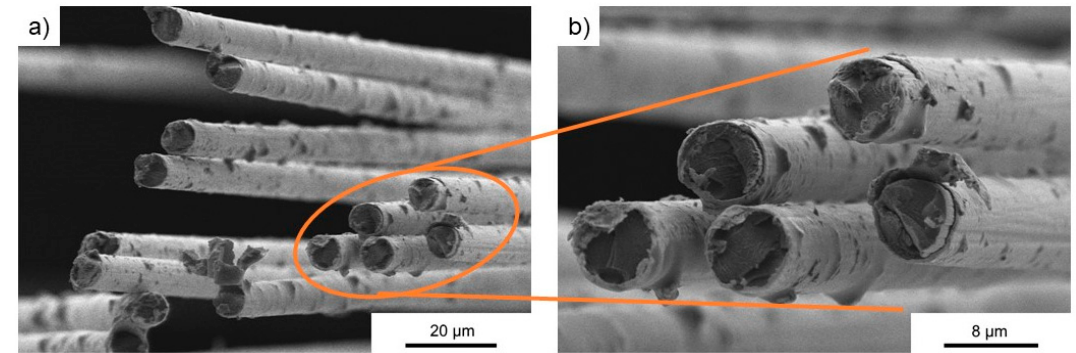
Figure 1. SEM cross-section images of the uncoated carbon fiber ( a ) overview picture, ( b ) marked section magnified.